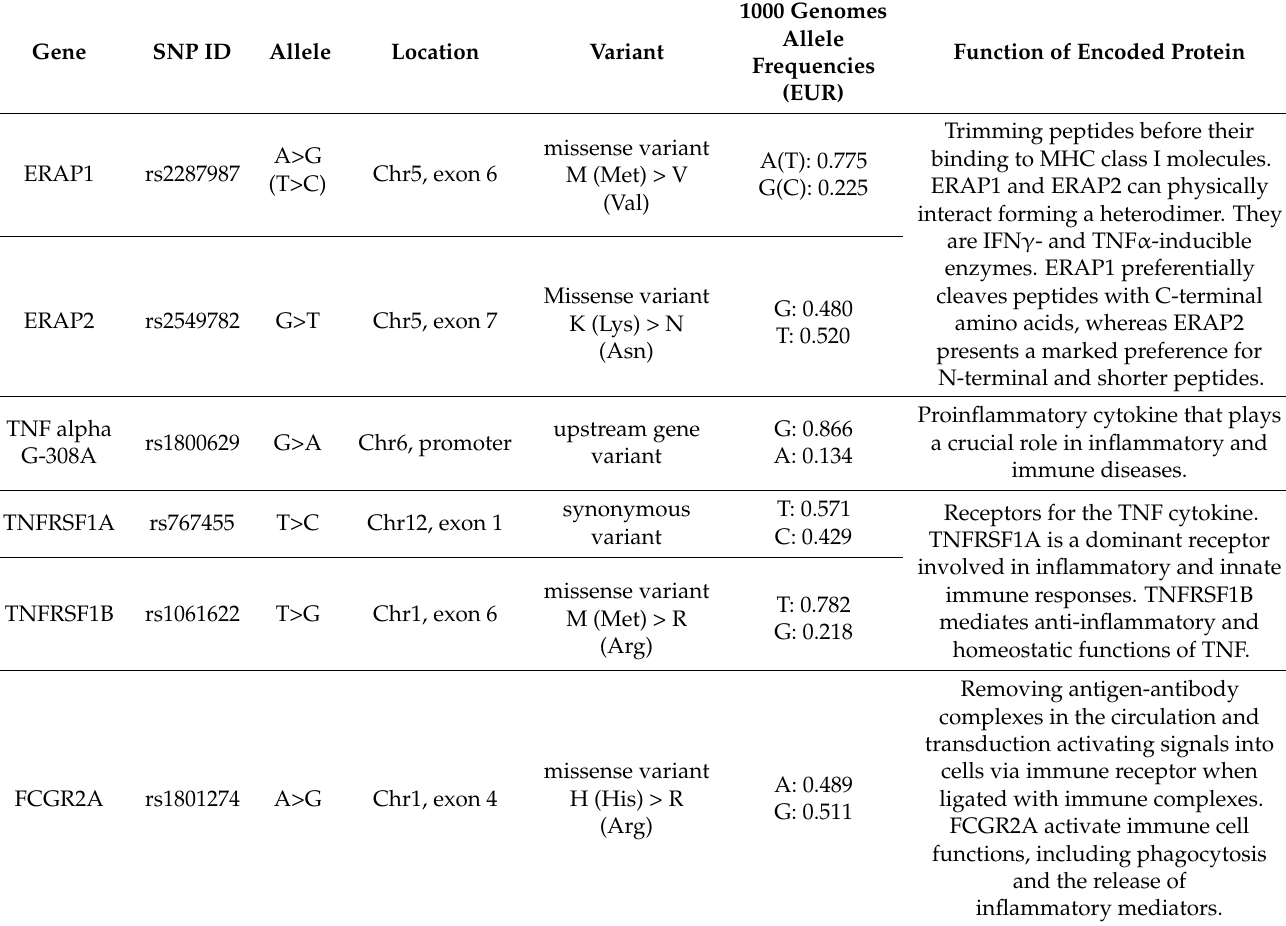
Table 2. Characteristics of selected